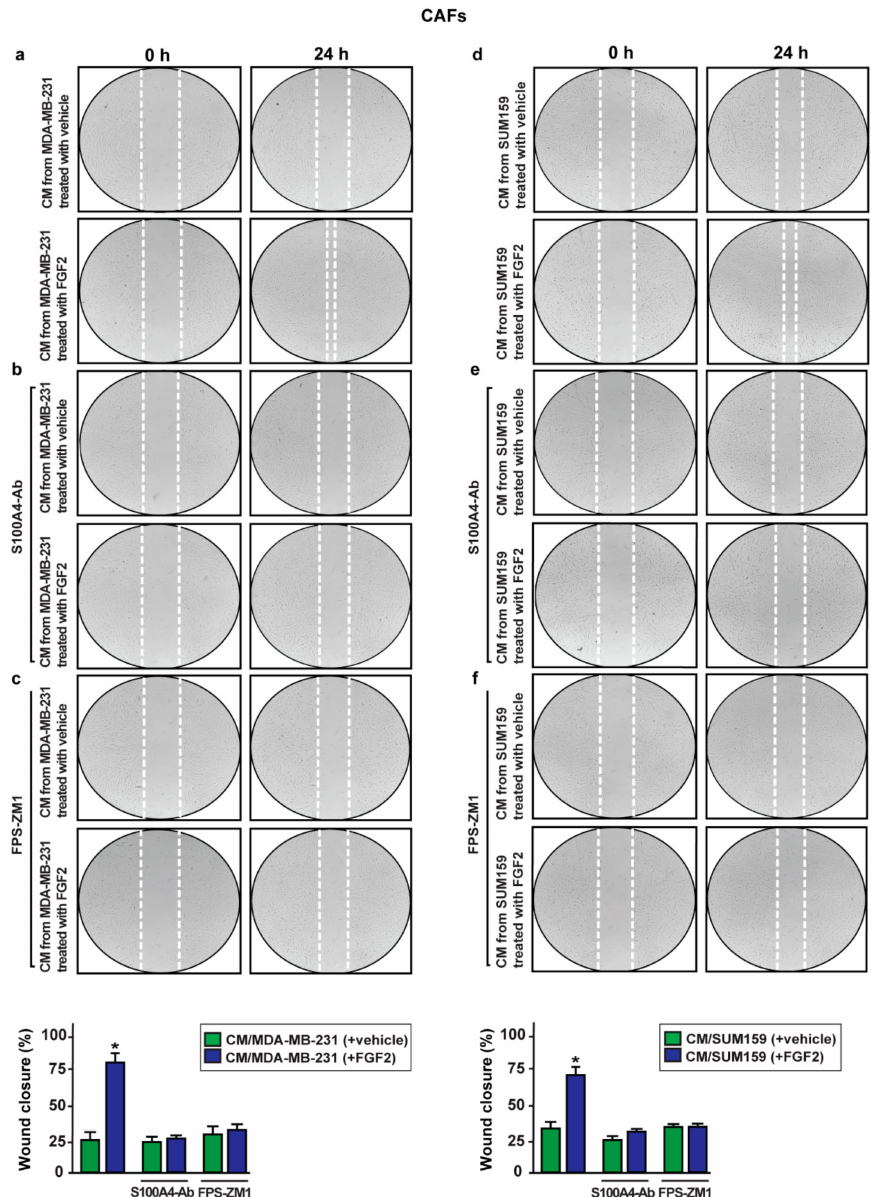
Figure 11. The paracrine action of the S100A4/RAGE axis promotes the migration of CAFs. ( a , d ) The migration of CAFs promoted by conditioned medium (CM) collected from MDA-MB-231 and SUM159 cells treated for 8 h with 25 nM FGF2 was no longer evident using CM collected from MDA-MB-231 and SUM159 cells treated for 8 h with vehicle and 25 nM FGF2 but immunodepleted for S100A4 by incubation with a mouse monoclonal antibody against S100A4 (S100A4-Ab) ( b , e ) or using 2 µ M RAGE antagonist FPS-ZM1 ( c , f ). Images were acquired at 0 and 24 h after scratching. Quantification of cell migration was expressed as % of wound closure. Data shown are the mean ± SD of three independent experiments performed in triplicate. (*) indicates p <